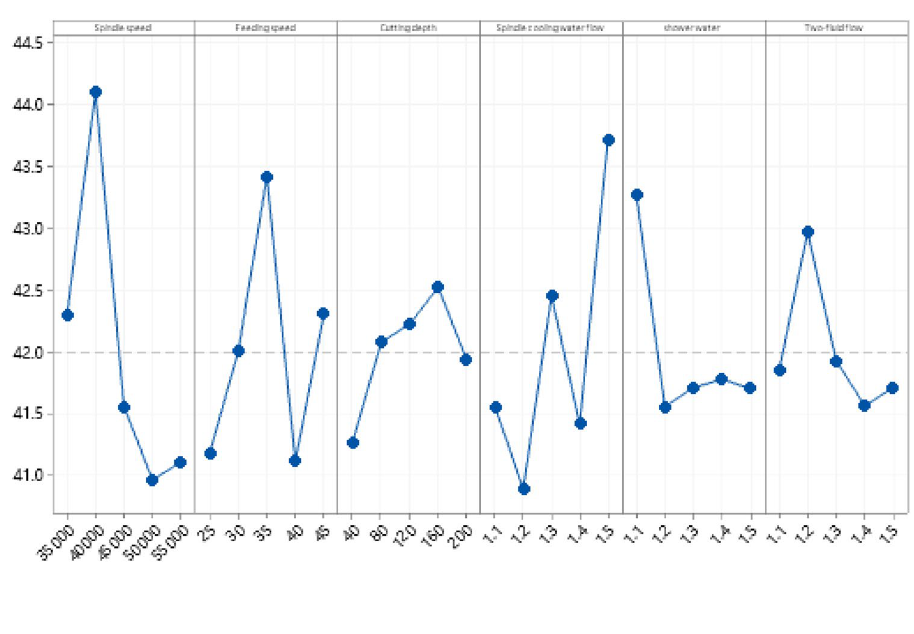
Fig. 6 main effects diagram